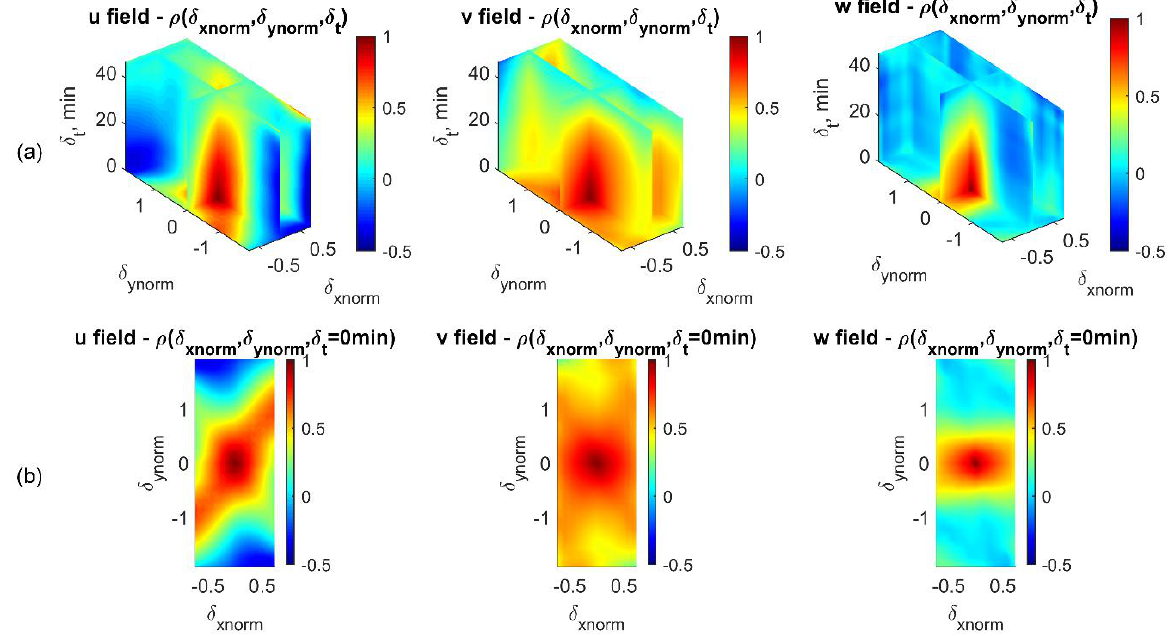
Figure 16. Spatio-temporal empirical correlation structures of 3D-T data ensembles under Cartesian coordinates. ( a ) Smooth representation of correlation structures for u , v , and w displacement fields (left to right). ( b ) Spatial correlation maps for u , v , and w displacement fields when 𝛿 𝑡 = 0 min (i.e., floor of ( a )).